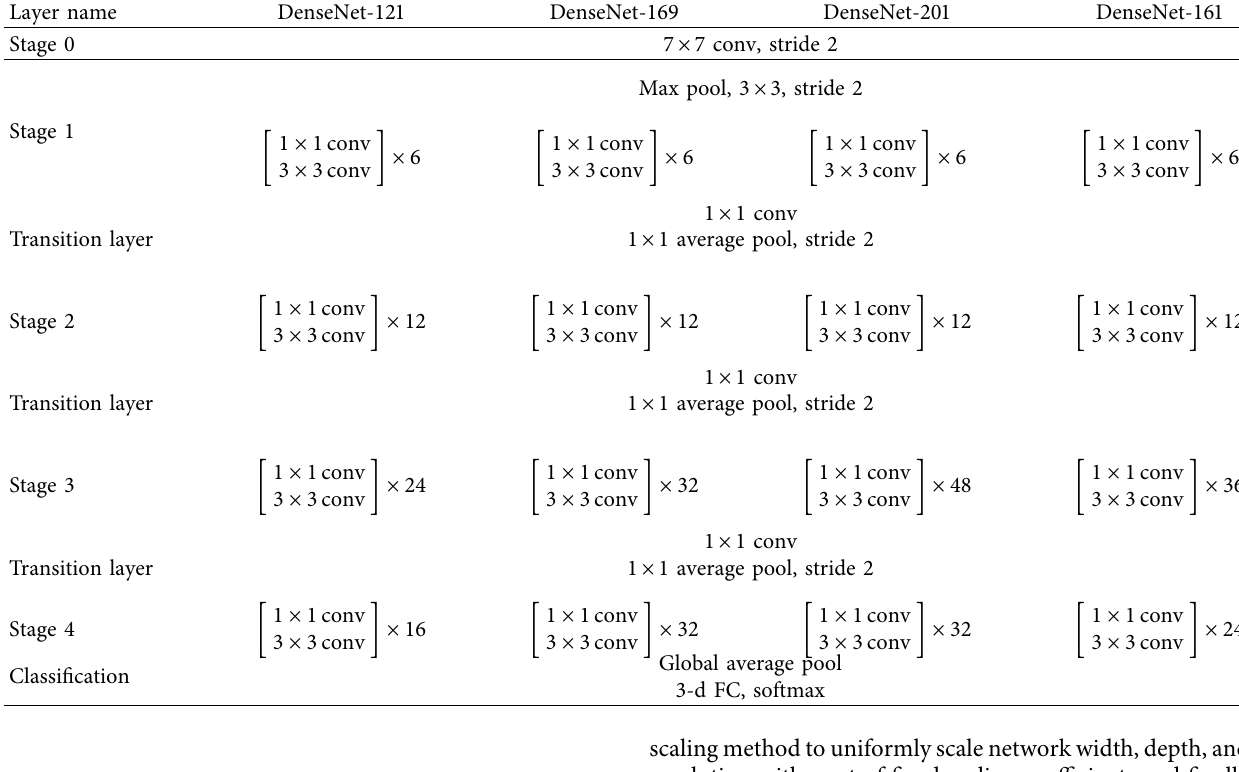
Table 4: Architectures of DenseNets. Note that each “conv” layer shown in the table corresponds to the sequence BN-ReLU-Conv. Layer name